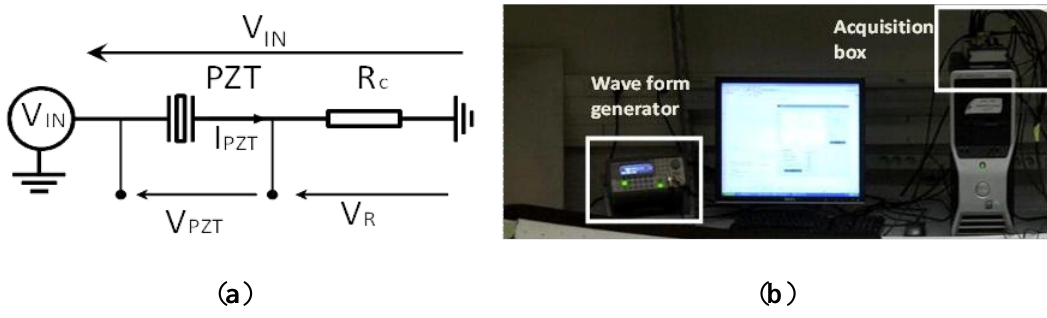
Figure 3. ( a ) Experimental measurement circuit. R Agilent 33220A arbitrary waveform generator monitored by a central computer over an USB VISA protocol, a PCI National instrument acquisition card of 2.5